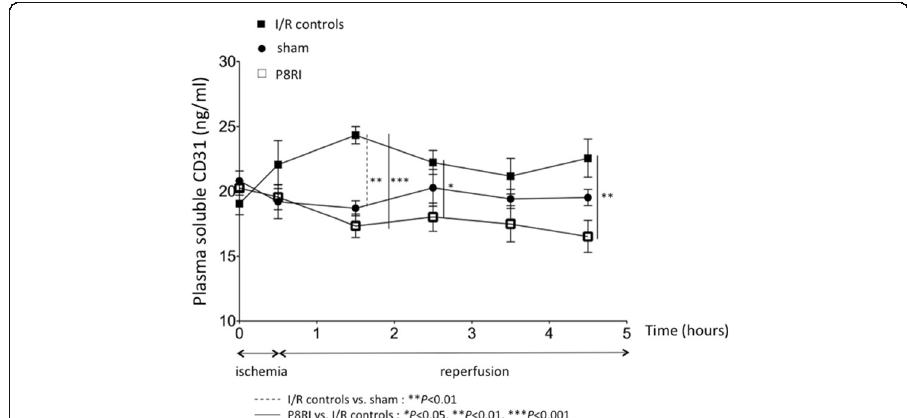
Fig. 4 Effect of P8RI on mesenteric ischemia/reperfusion-induced shedding of CD31 into plasma. The shedding of CD31 into plasma was assessed by the detection in plasma of the soluble CD31. The concentration of soluble CD31 in plasma was lower in the P8RI group than in I/R controls at 1 h (*** P <0.001), 2 h (* P <0.05), and 4 h (** P <0.01) of reperfusion after mesenteric ischemia